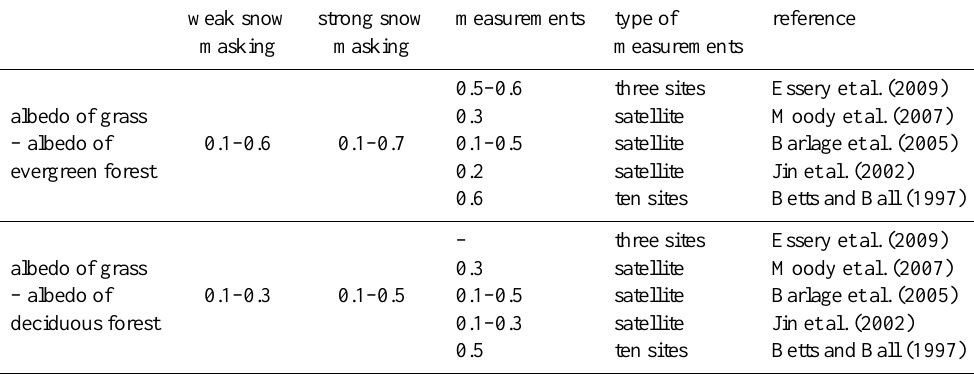
Table 2. Strength of snow masking of MPI-ESM and values from literature. weak snow